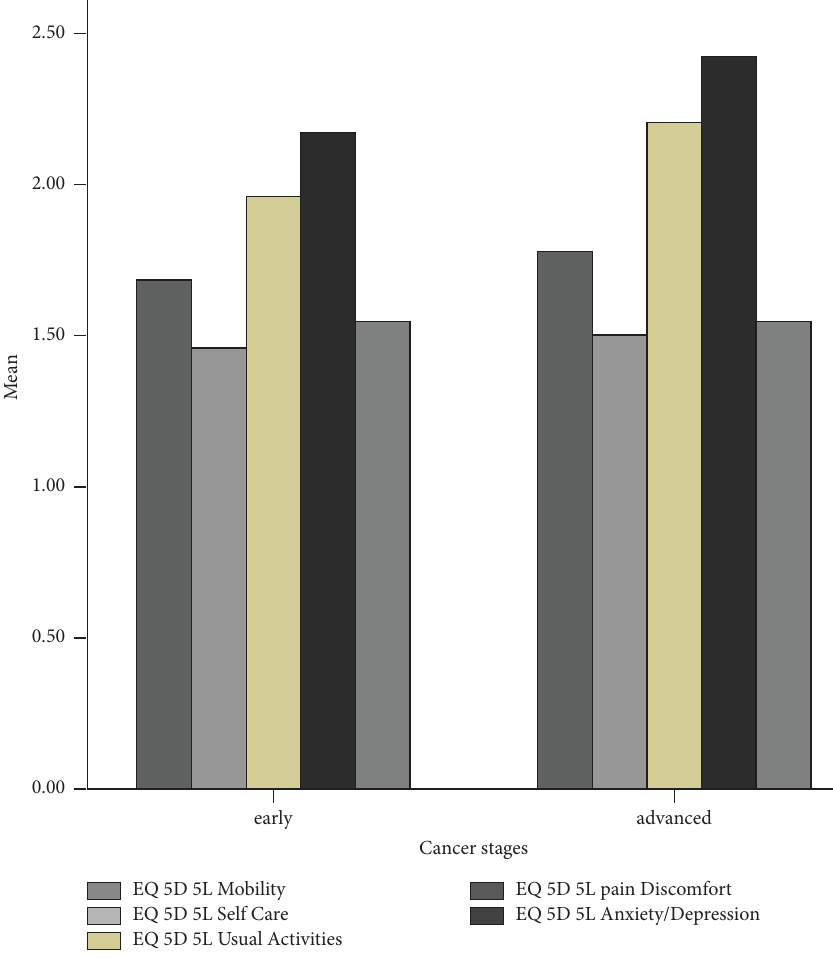
Figure 6: All domains of the